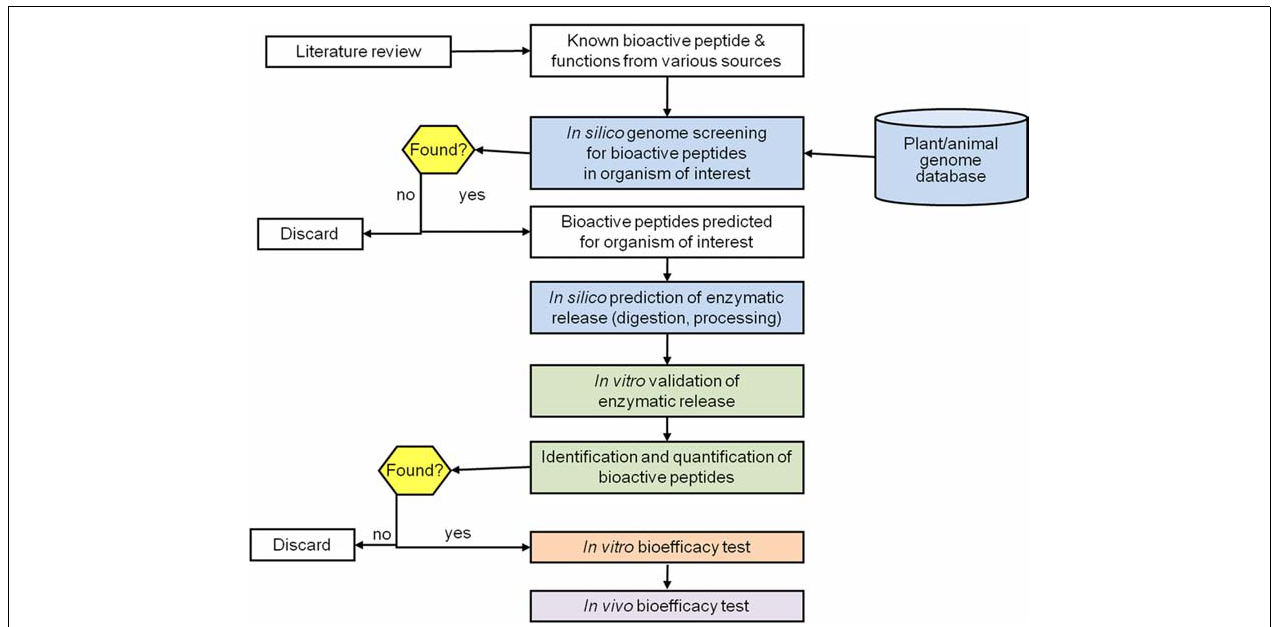
FIGURE 3 |Workflow of bioinformatics-driven discovery of bioactive peptides. Blue: bioinformatics; green: peptidomics; orange: in vitro ; purple: in vivo